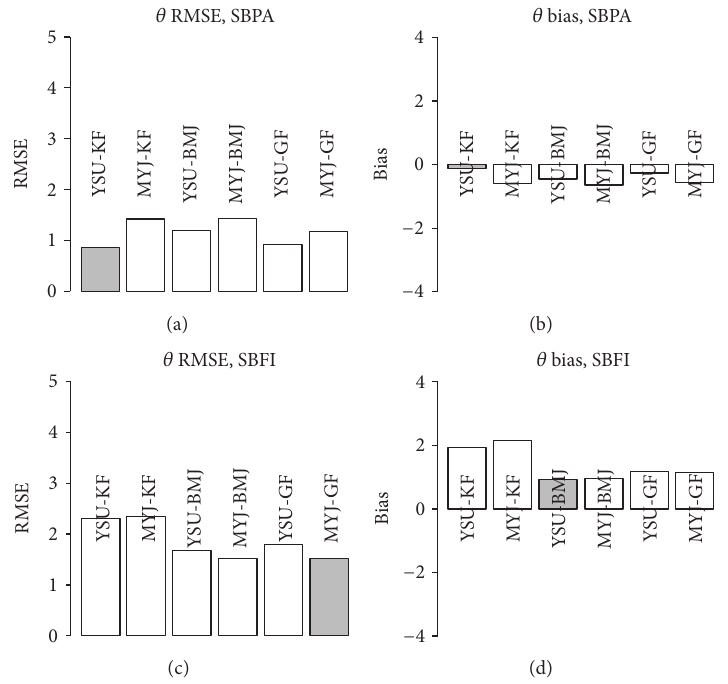
Figure 8: Root mean square error [(a) and (c)] and bias [(b) and (d)] for the simulated profiles of potential temperature at SBPA [(a)-(b)] and SBFI [(c)-(d)] sites valid at 12Z 21 October 2008. Shaded bars indicate the simulations with lowest RMSE and